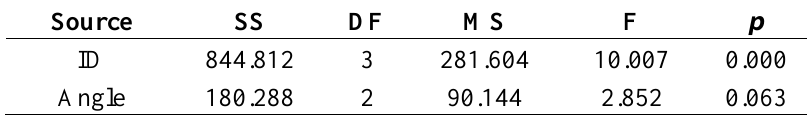
Table 8. ANOVA results for the error rate of the teach pen operation.